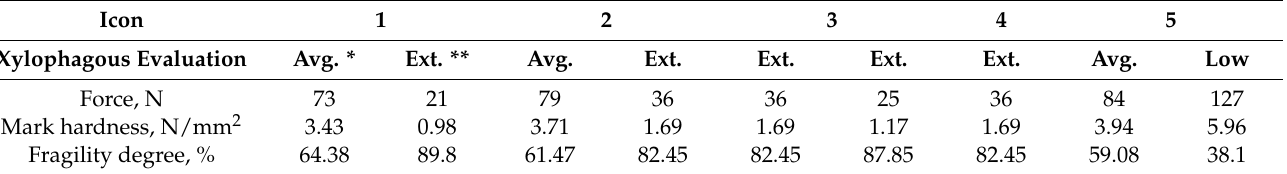
Table 3. Degree of fragility with the Mark hardness method.